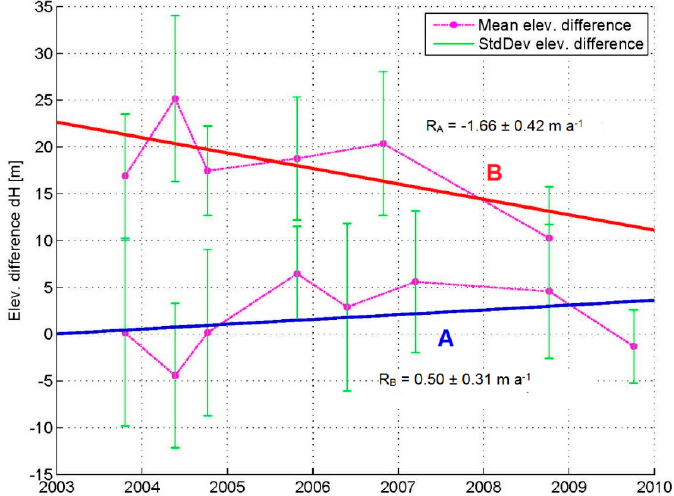
Figure 3. Distributions of the mean elevation differences and temporal glacial thickness change trends between 2003 and 2009 at the glaciated areas A and B.